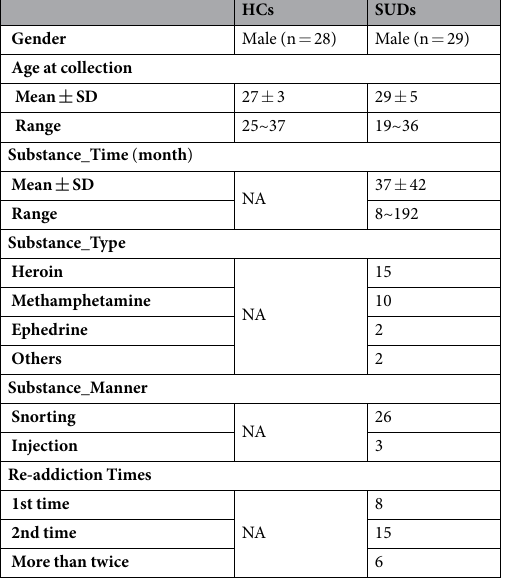
Table 2. Characteristics of 57 Participants. Data are shown as median (interquartile